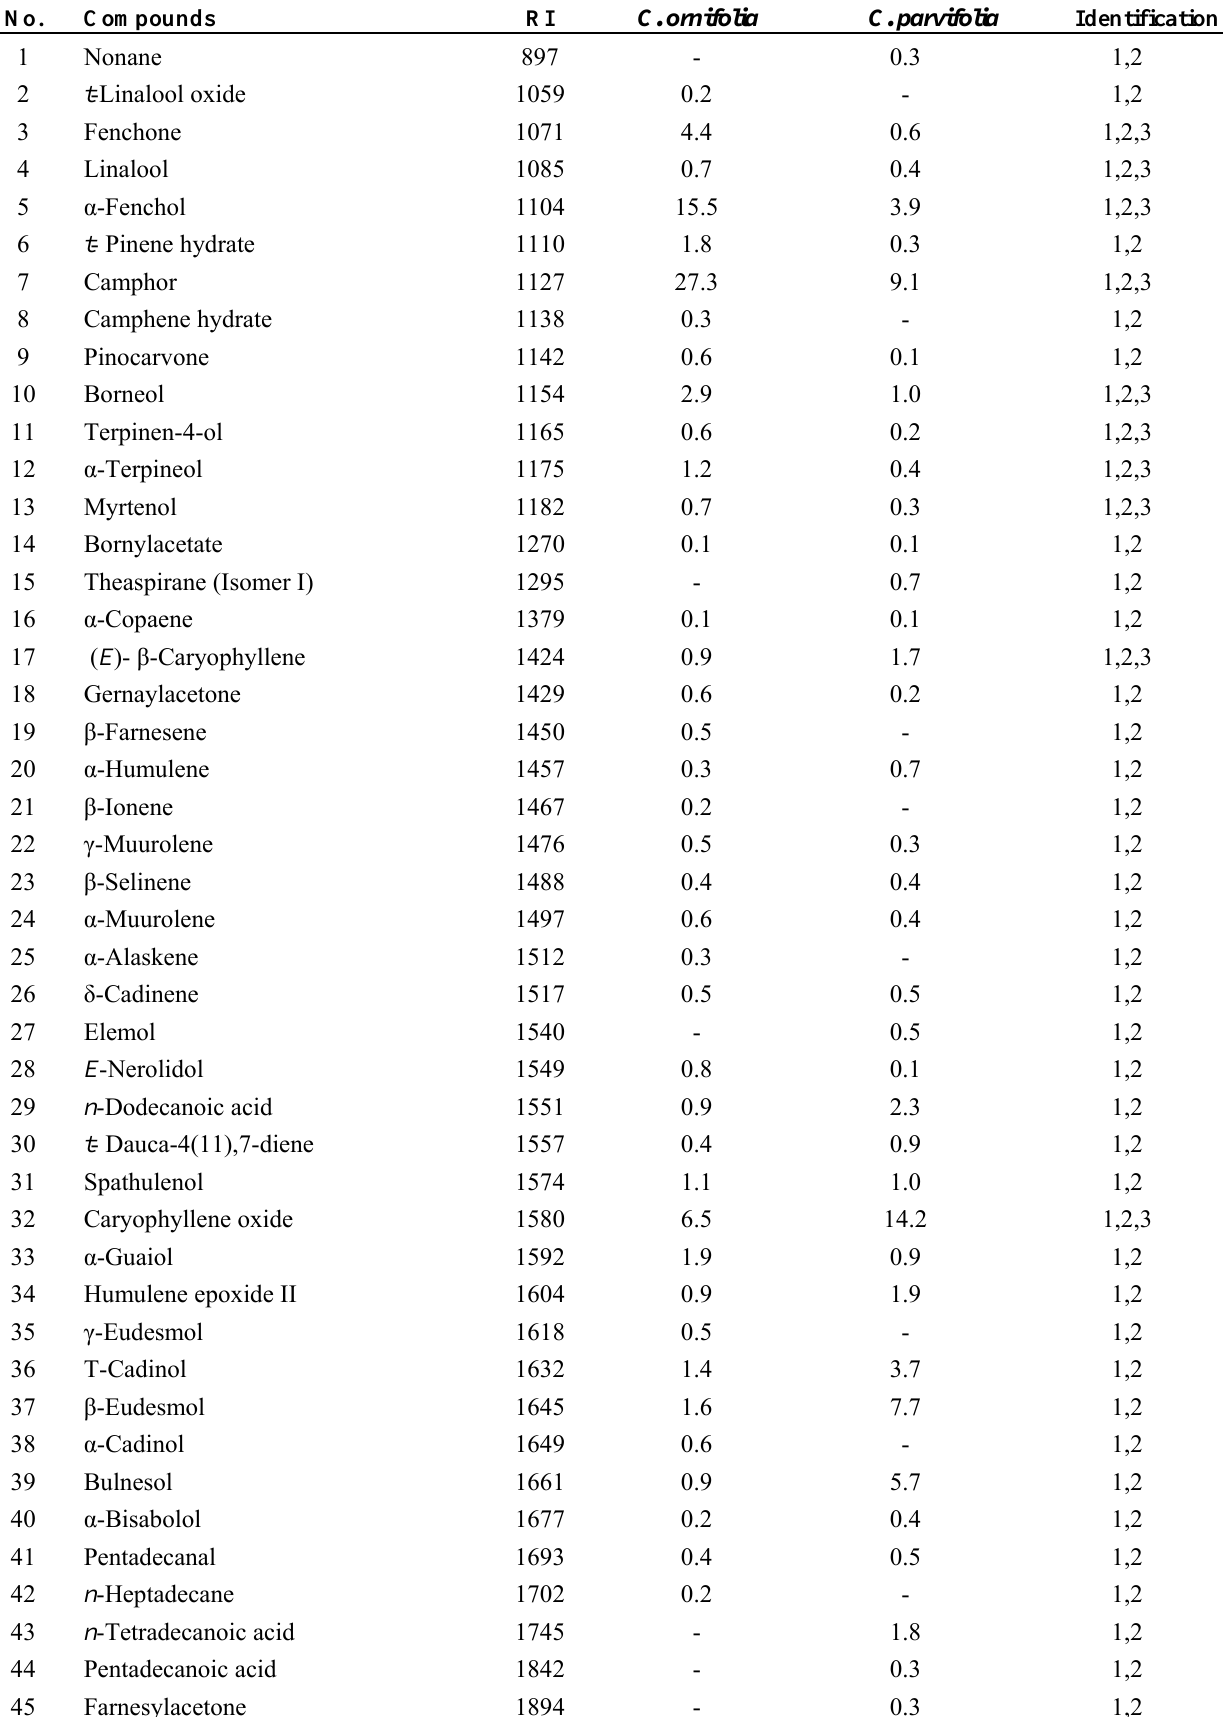
Table 1. Essential oil composition of C. ornifolia and C. parvifolia